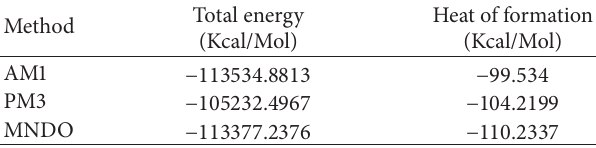
Table 2: Total energy and heat of formation of